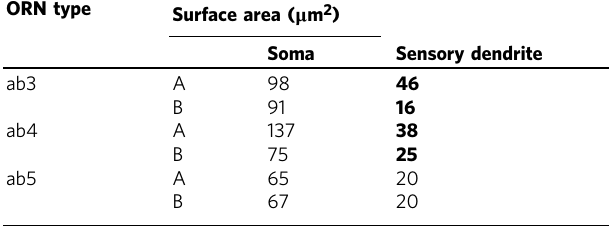
Measured input parameters are in non-bold (see also Supplementary Table 2), and fi tted values in bold